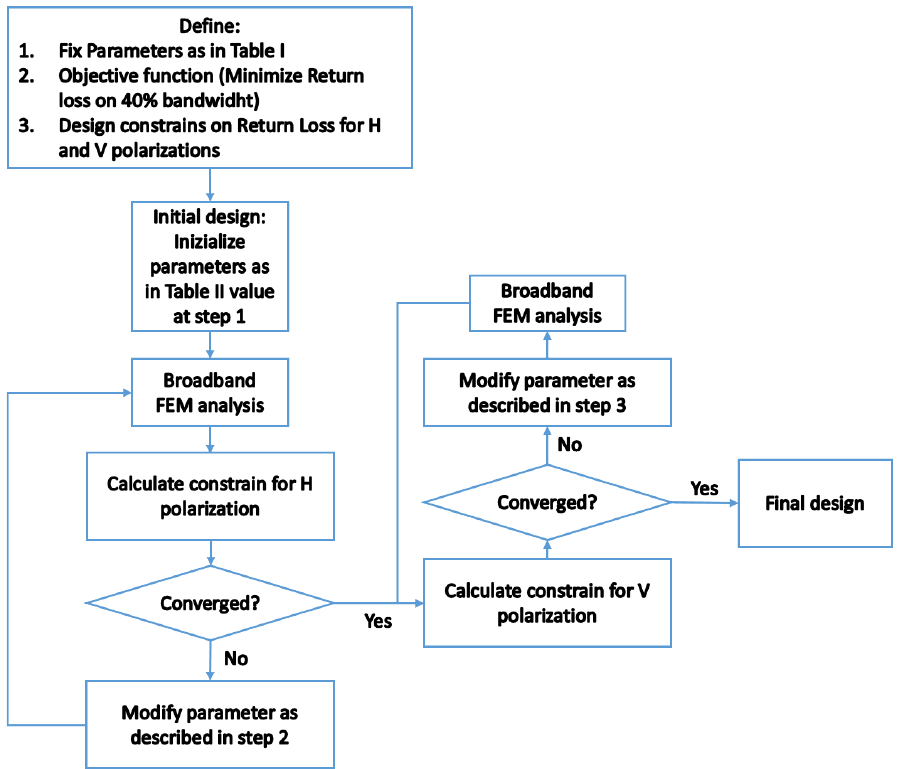
Figure 2. Flow chart of optimization